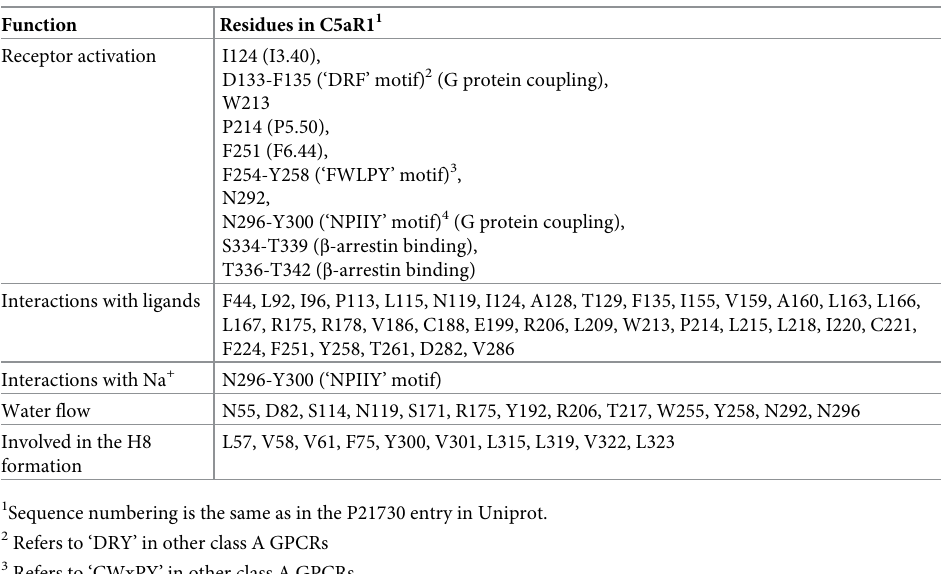
Table 1. The most important residues in C5aR1, based on: [16–18].